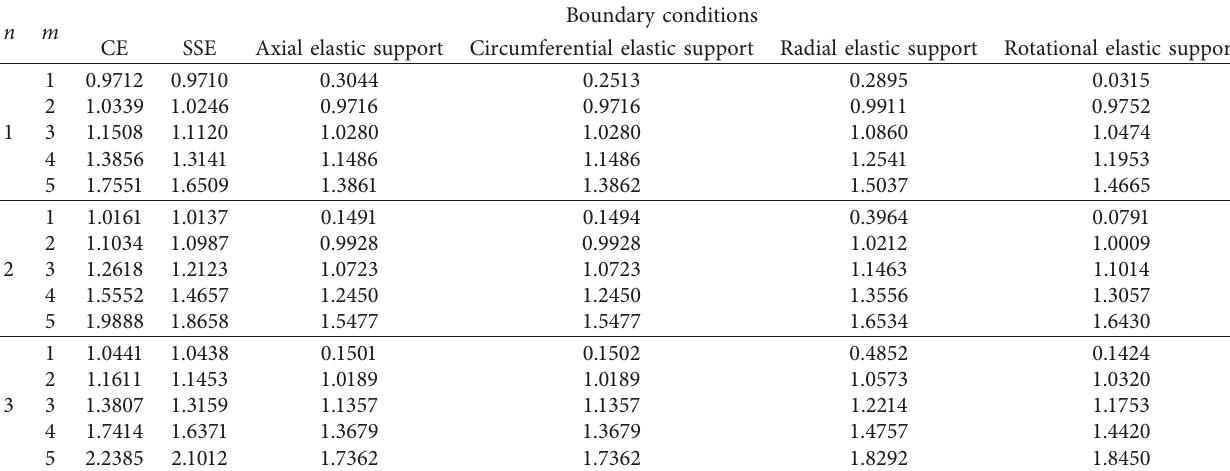
Table 8: Nondimensional frequency parameter of uniform 45 degrees spherical cap with different edge